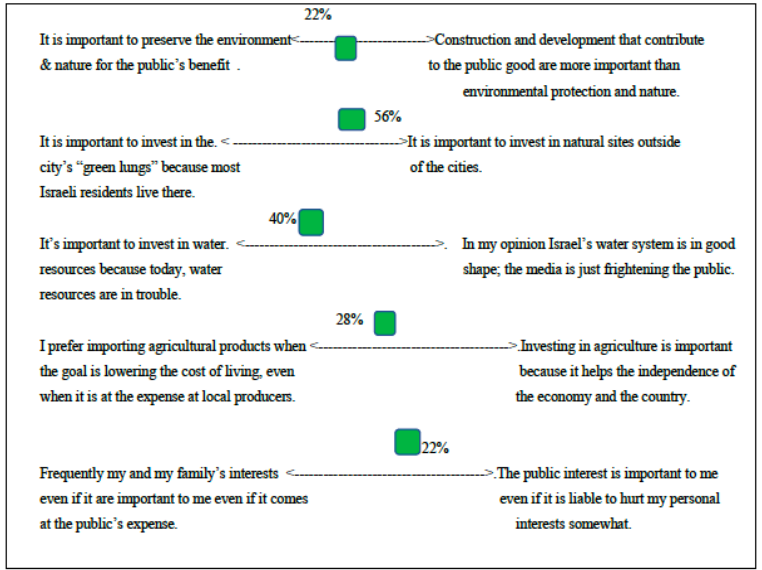
Figure 3. Environmental values clarification—general public.